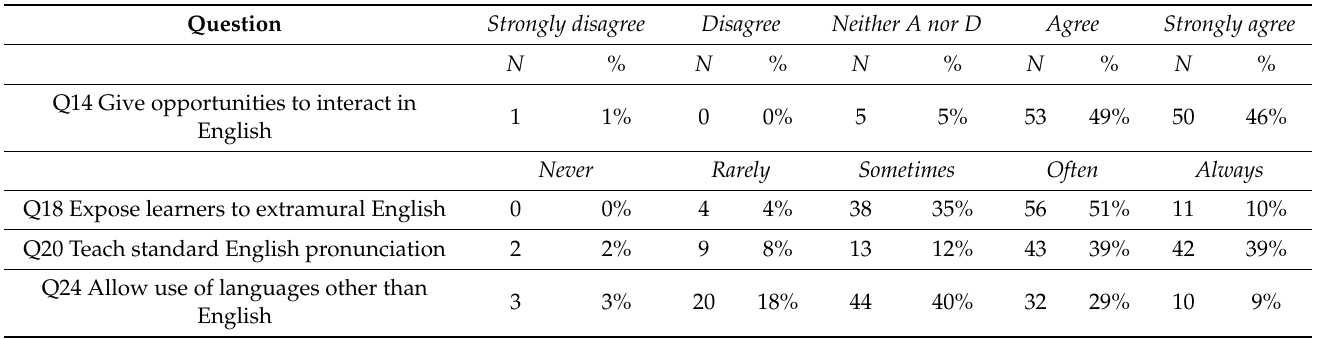
Table 4. Teachers’ reported teaching practices for English